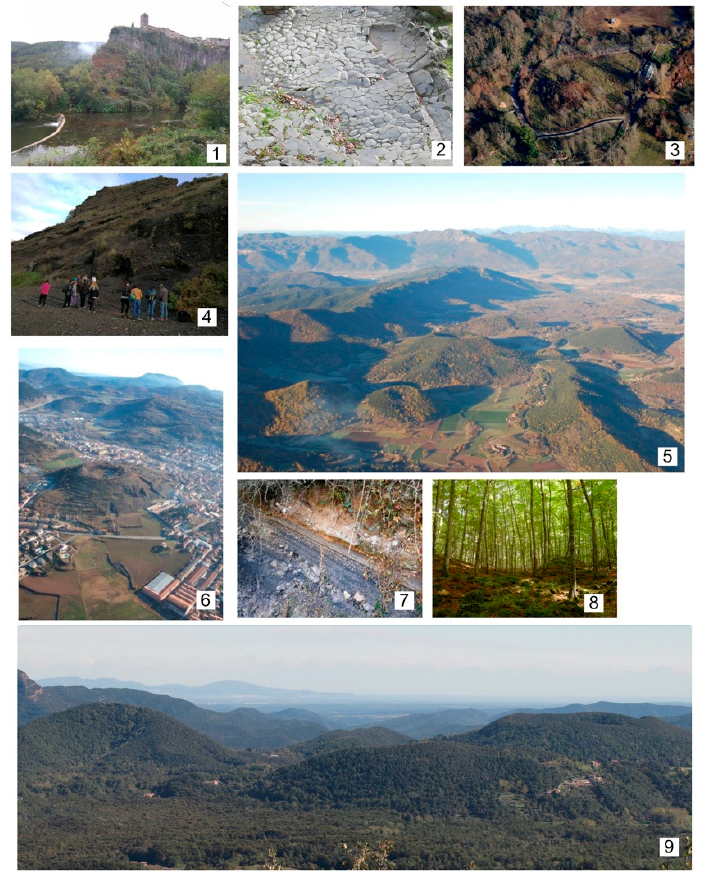
Figure 4. Photographs of the main geosites. ( 1 ) Castellfollit de la Roca lava cliff; ( 2 ) Detail of Sant Joan Les Fonts (Moli Fondo quarry) lava flows; ( 3 ) Aerial view of a rootless scoria cone at the Pedra Tosca Park; ( 4 ) Montsacopa volcano quarry; ( 5 ) Aerial view of the Croscat and Santa Margarida volcanoes; ( 6 ) Aerial view of the Montsacopa volcanoes; ( 7 ) Pyroclastic deposits at the Can Tià volcano quarry; ( 8 ) La Fageda d’en Jordà lava flow; ( 9 ) Landscape view of Crosca (left) and Santa Margarida (center) volcanoes from Xenacs.